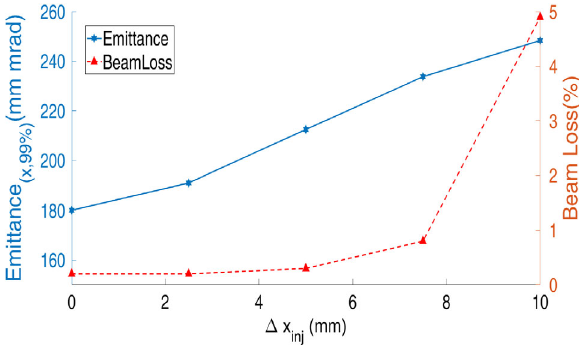
FIG. 3. Effects of the injection orbit mismatch on emittance (blue solid line) and beam loss (red dashed